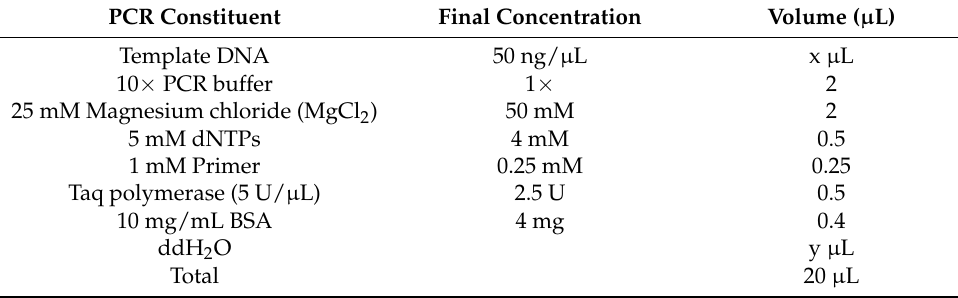
Table 2. Component in each total reaction volume.